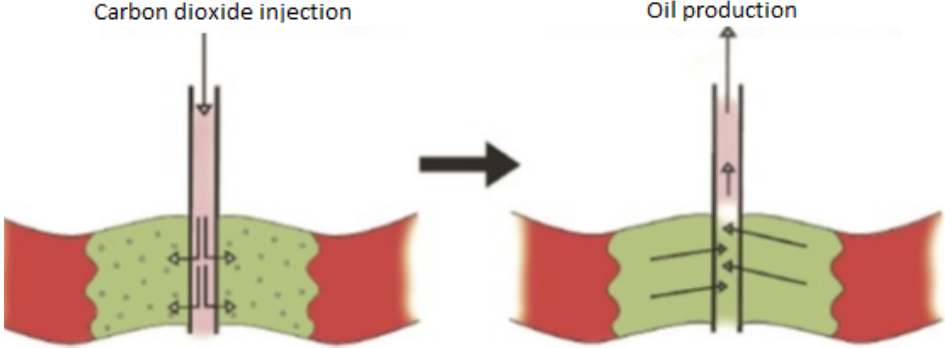
Figure 5. The principle of the CO 2 huff-n-puff process